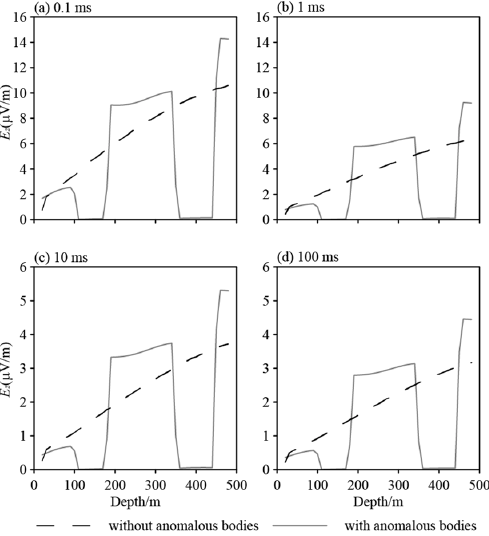
Figure 8. Responses of receivers in the borehole in different times for the synthetic model in Figure 7 with and without anomalous bodies.